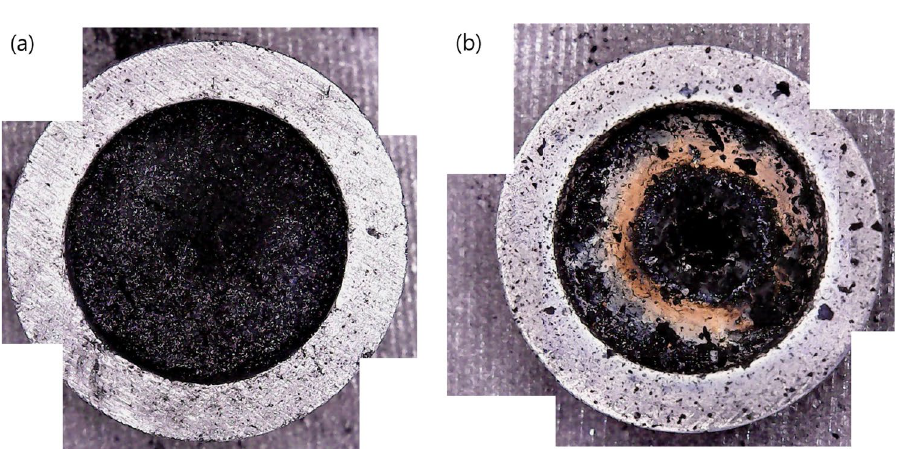
Figure 2. Digital images of the samples contained in a graphite crucible after ( a ) 25 W and ( b ) 50 W laser beam